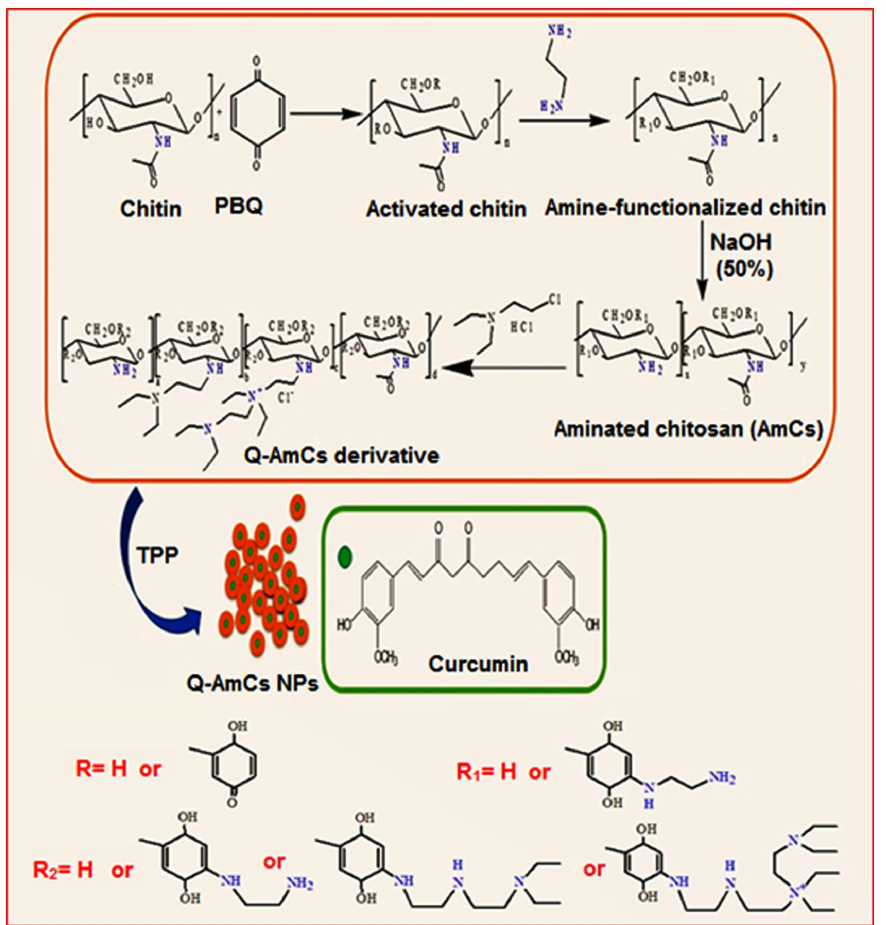
Figure 7. A schematic diagram for the synthesis of quaternized aminated chitosan (Q-AmCs)